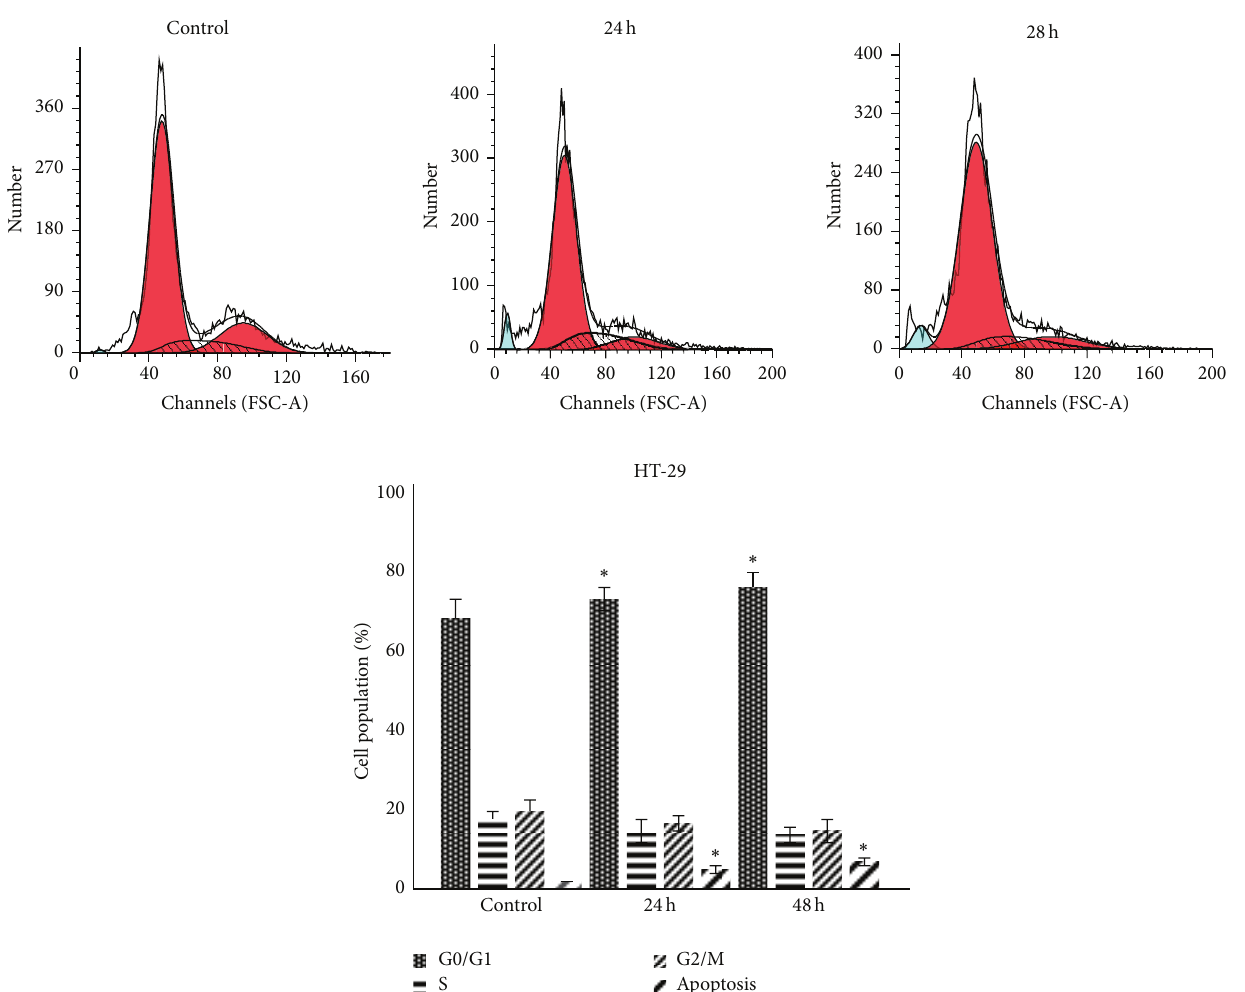
Figure 5: Effect of Cu(BrHAP) 2 on cell cycle progression in HT-29 cells as assessed by flow cytometry. After incubation with Cu(BrHAP) 2 for 24 and 48 h, significant cell cycle arrest in the G 1 phase was observed.